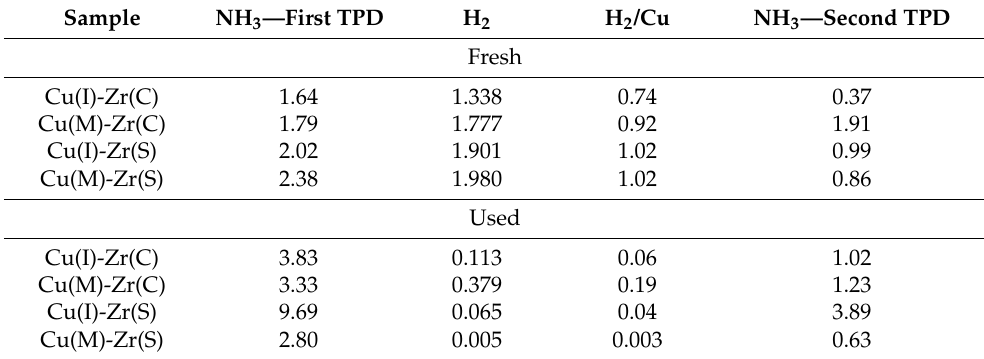
Table 2. NH 3 and H 2 amounts (mmol/g) and H 2 /Cu ratios measured during NH 3 -TPD and H 2 -TPR tests over fresh and used samples.